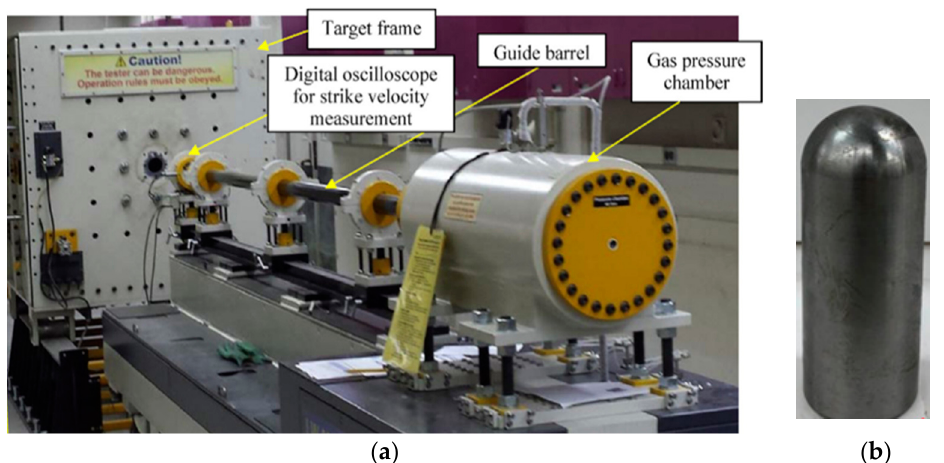
Figure 2. ( a ) Gas gun for projectile impact testing of targets; ( b ) Steel projectile with a hemispherical nose, 40 mm in diameter and 100 mm in height.